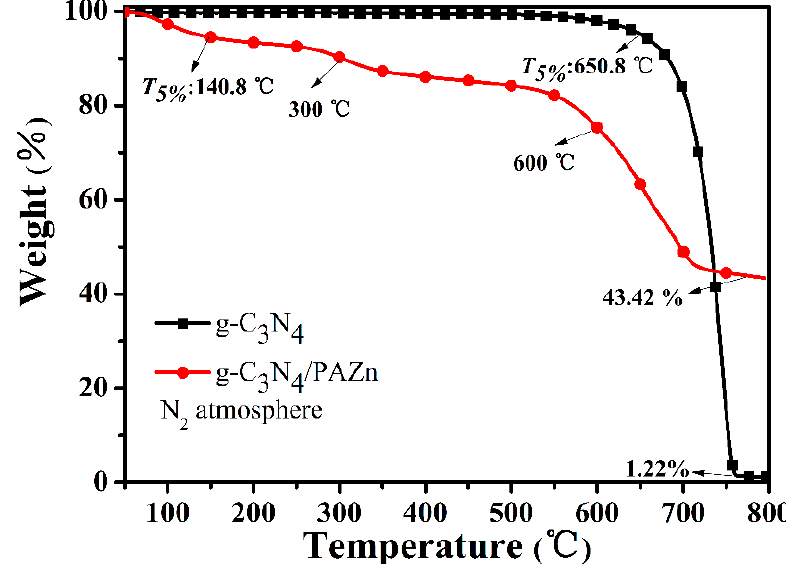
Figure 3. TGA curves of g-C 3 N 4 and g-C 3 N 4 /PAZn under N 2 atmosphere.